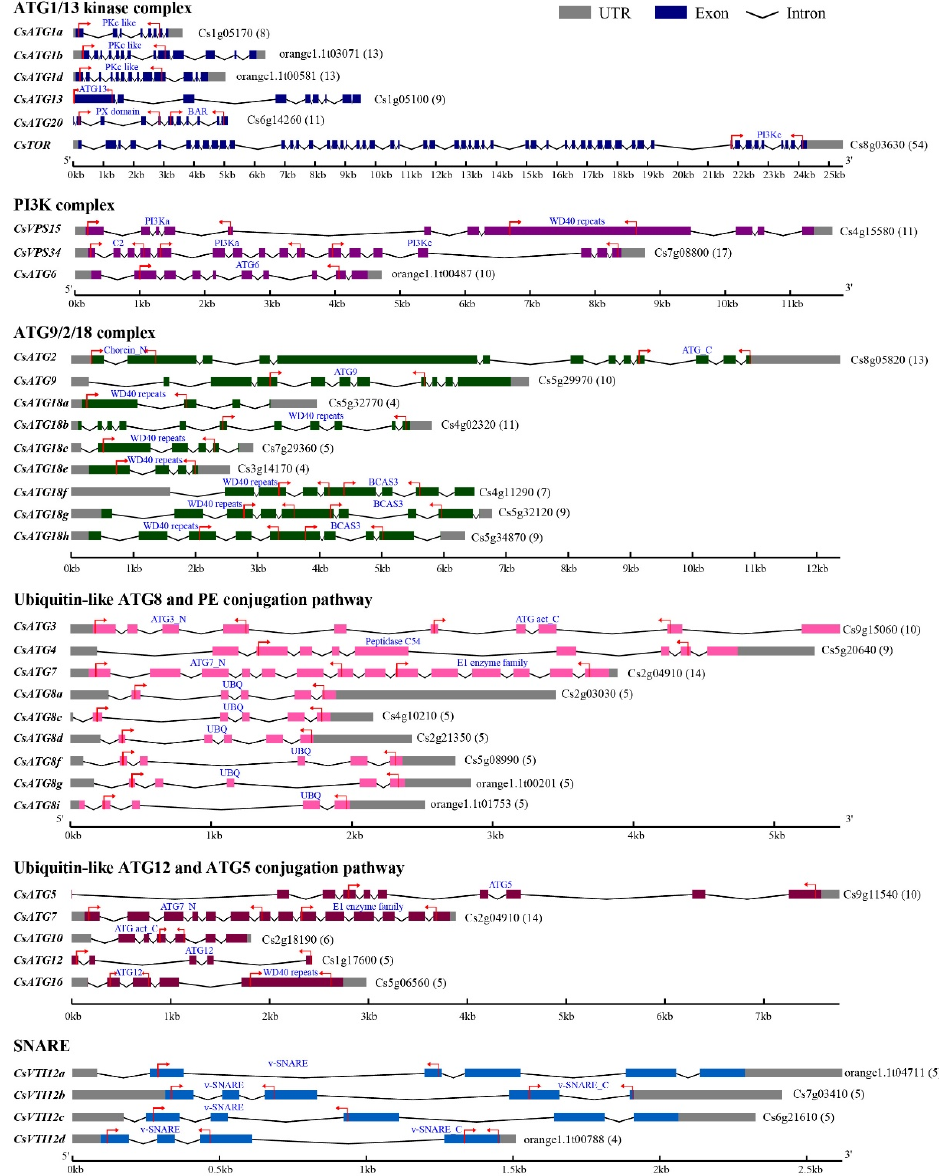
Figure 3. Gene structures and conserved domains of CsATGs. The detailed intron-exon structures and domains of all CsATGs were predicted in the Gene Structure Display Server and the NCBI Conserved Domain Database, respectively. The results are shown and listed according to their functional classifications. Arabic numerals in the parentheses after each gene ID represent exon number. The arrows show the start and end positions of domains. Full names of the conserved domains are listed in the Abbreviations section.